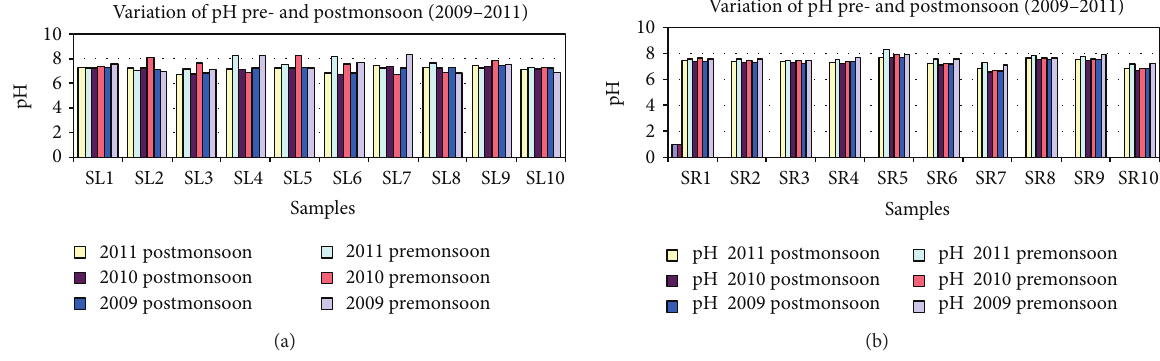
Figure 2: (a) Observations of pH in water from the sites SL1–SL10 for the pre- and postmonsoon of 2009–2011. (b) Observations of pH in water from the sites SR1–SR10 for the pre- and postmonsoon of 2009–2011.